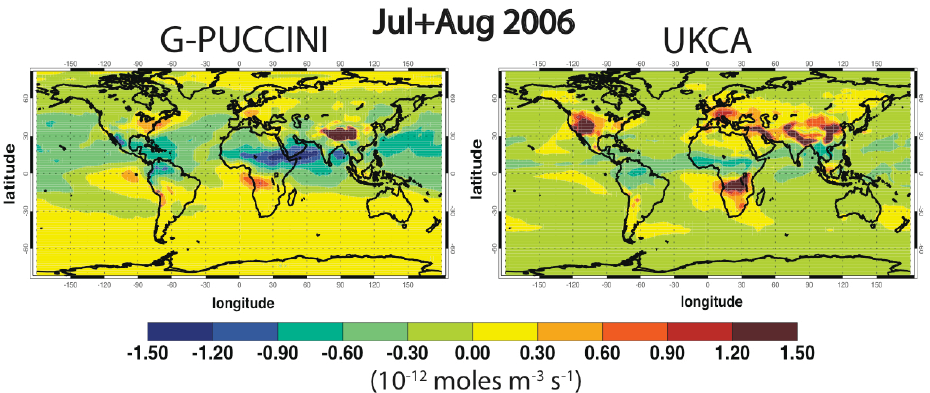
Fig. 10. Net chemical tendency of middle/lower free tropospheric (800–400hPa) O 3 in July–August 2006 for the G-PUCCINI and UKCA unperturbed runs